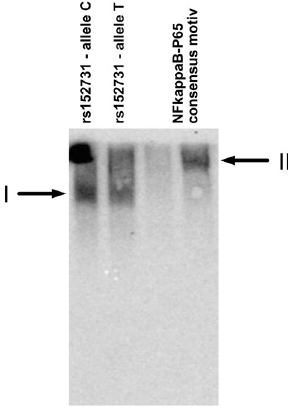
Figure 3. Electrophoretic mobility shift assay and subsequent protein sequencing (EMSA-PSeq). The dsDNA probes for SCNN1B SNP rs152731 allele C, SCNN1B SNP rs152731 allele T and the NFkappaB-P65 consensus motif 16 were incubated with T84 nuclear extract. After non-denaturing 7% polyacrylamide electrophoresis,